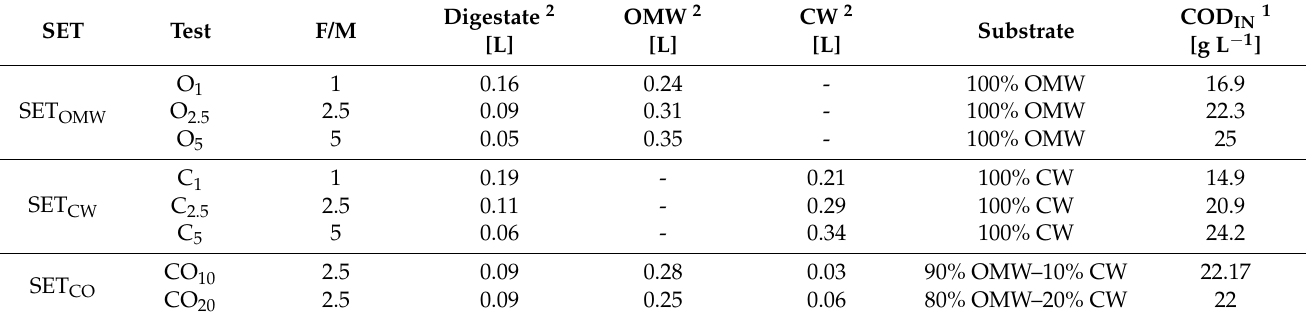
Figure 1. Experimental setup. Table 2. Characteristics of reactors.